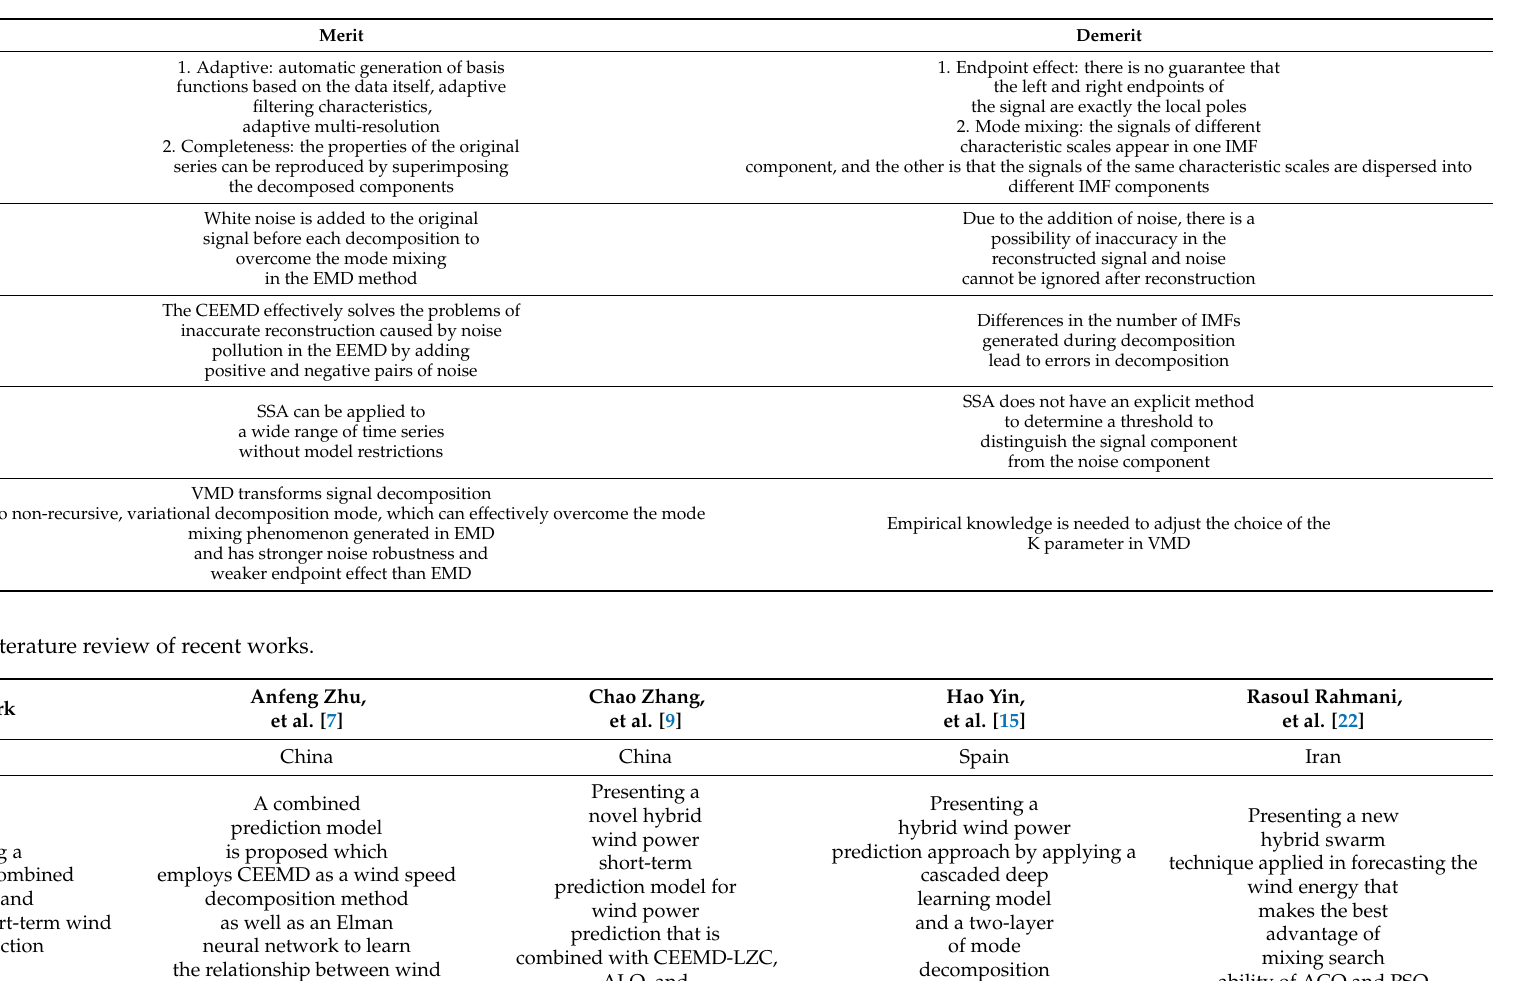
Table 1. Merit and demerit of different decomposition methods.